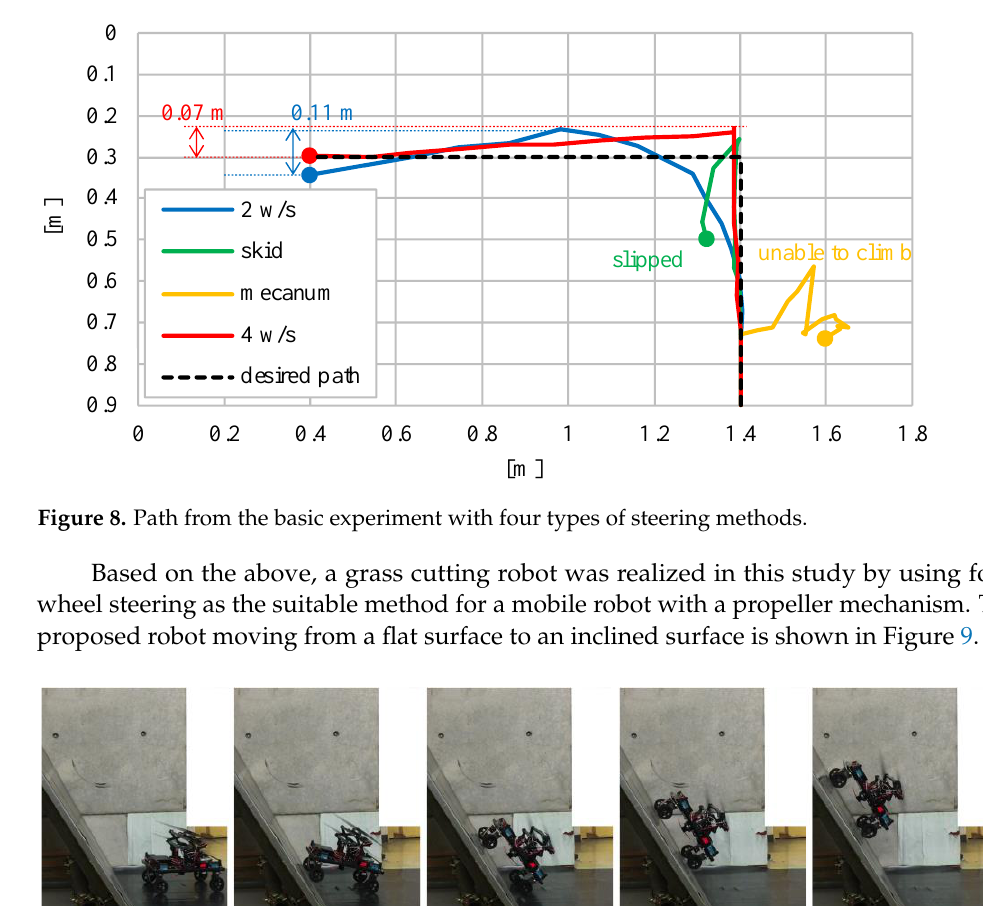
Figure 7. Experiment of moving on a rubber slope with four steering methods. ( a ) Two-wheel steer- ing, ( b ) skid steering, ( c ) Mecanum wheels, ( d ) four-wheel steering, and ( e ) experimental setting.